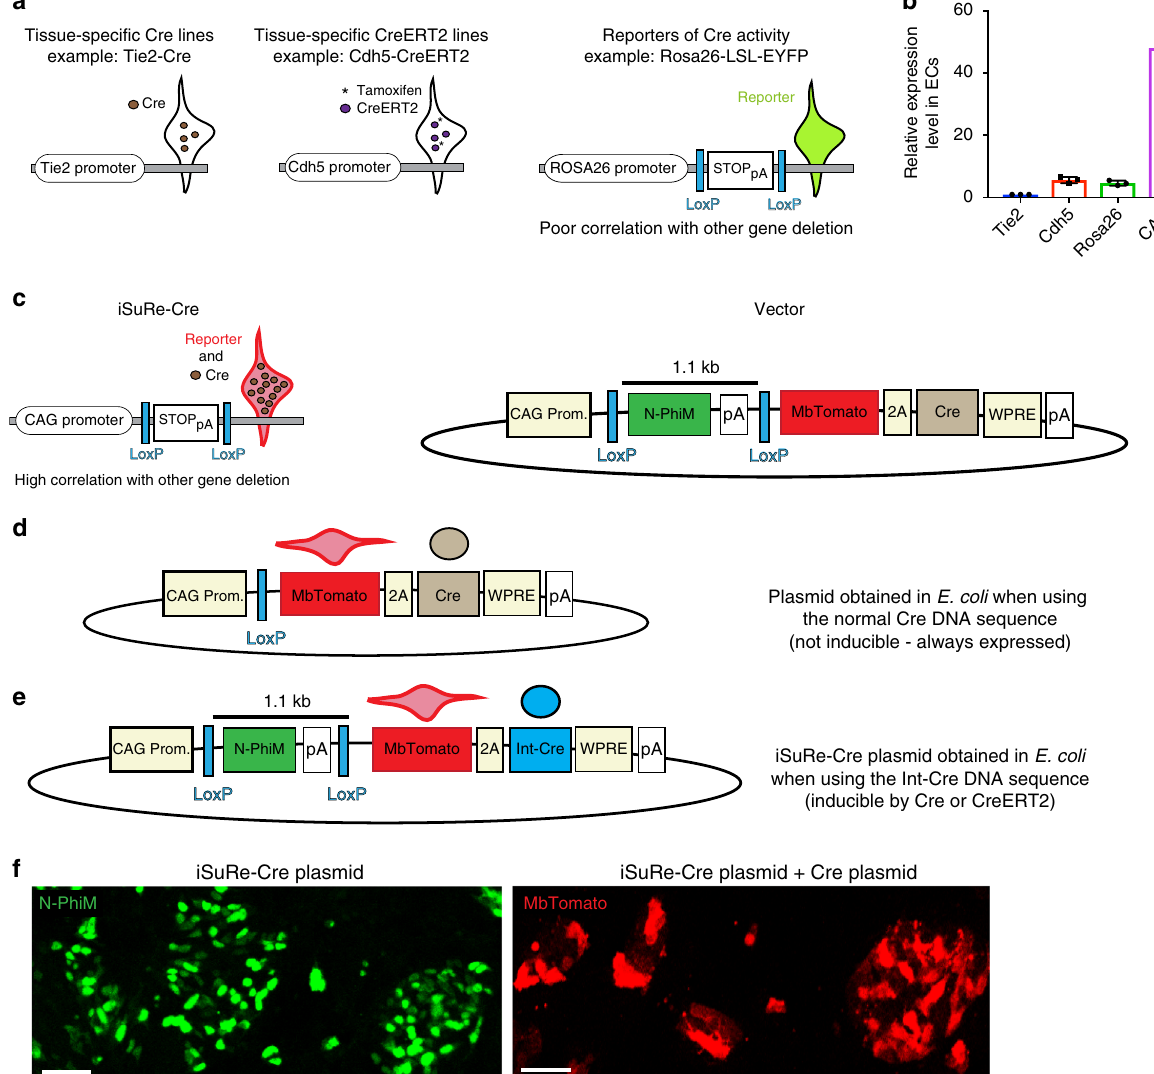
Fig. 1 Design and pre-validation of iSuRe-Cre plasmids. a , b Cre or CreERT2 expression from transgenes carrying gene-speci fi c promoters (i.e. Tie2 or Cdh5 ) is variable and relatively weak (endothelial RNA samples, n = 3 animals). In addition, in the case of CreERT2-expressing alleles, tamoxifen needs to be provided to induce activity, of only a fraction of available CreERT2 proteins, and in a limited time window. Due to the variability in Cre expression and induced activity, commonly used Cre activity ROSA26 reporter alleles do not guarantee full recombination of other fl oxed alleles in the same cell. c The new iSuRe-Cre genetic tool enables stronger (CAG promoter driven) and constitutive co-expression of a reporter (MbTomato) and Cre, which is expected to increase the correlation between reporter expression and gene deletion. LoxP, short DNA sequences recognized and recombined by Cre; N-PhiM, nuclear-localized and mutated PhiYFP; pA, Sv40 polyadenylation sequence; 2 A, self-cleaved viral 2 A peptide to guarantee equimolar expression but separate localization of the reporter and Cre. WPRE, Woodchuck hepatitis virus posttranscriptional regulatory element to enhance expression. d Vectors containing the normal Cre sequence always had deletion of the N-PhiM-pA cassette in E. coli , rendering them non-inducible. e The use of an intron- containing Cre sequence (Int-Cre) disrupts Cre expression and function in E. Coli , allowing the generation of a Cre-inducible, Cre-expressing vector (iSuRe- Cre). f Confocal micrographs showing that cells transfected with iSuRe-Cre plasmids express the N-PhiM protein in the nuclei. If cells are co-transfected with iSuRe-Cre and Cre-expressing plasmids, the LoxP-N-PhiM-pA-LoxP cassette is recombined/deleted and MbTomato-2A-Int-Cre is expressed. Scale Bars 55 μ m. Error bars indicate StDev. Source data are provided as a Source Data fi